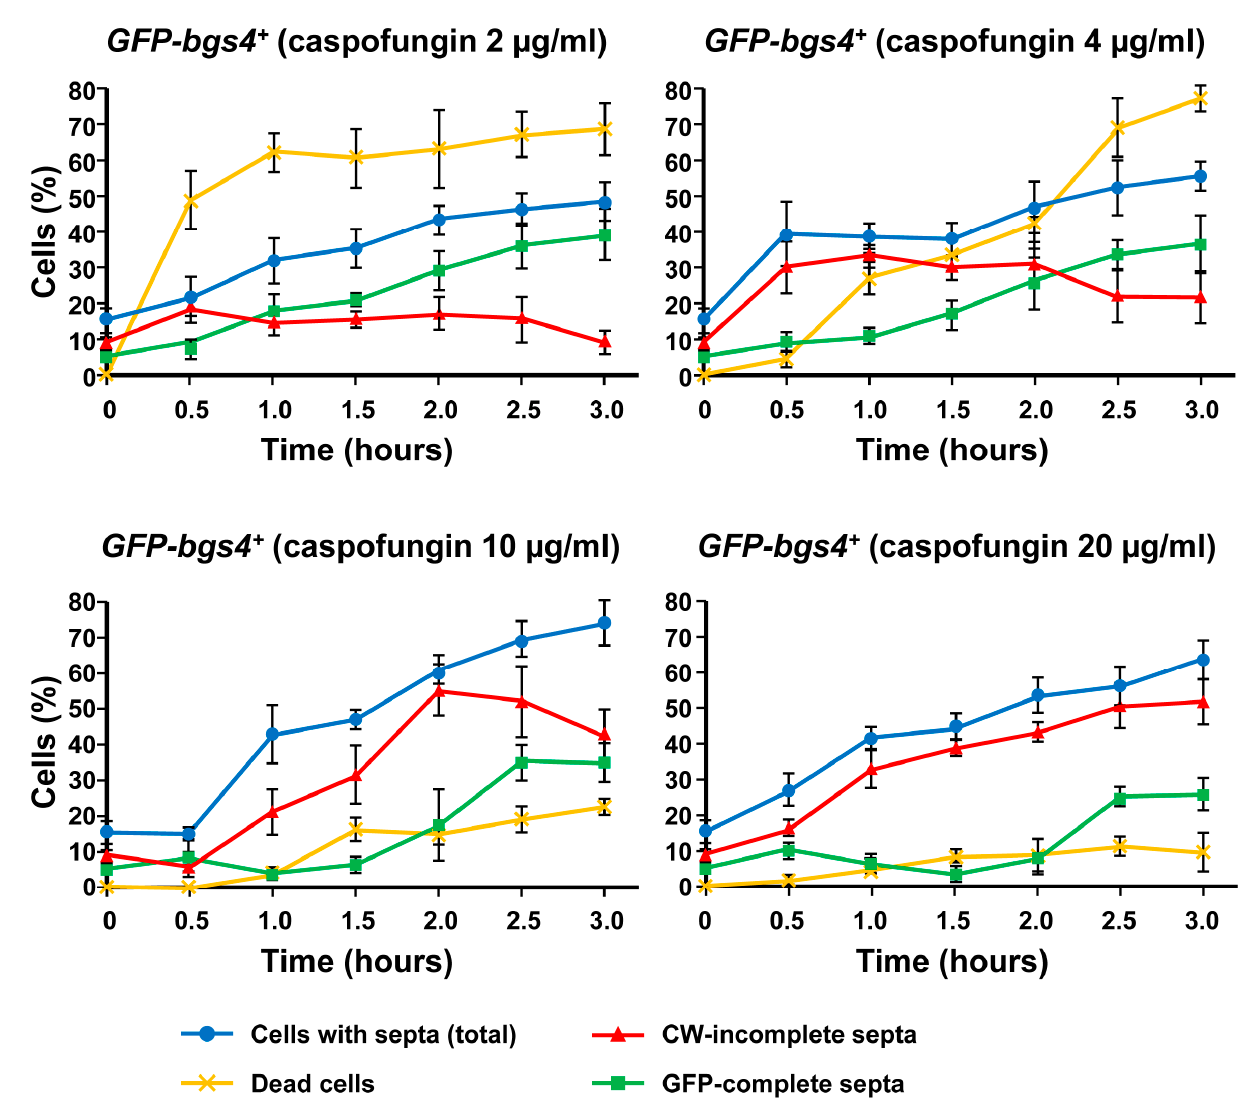
Figure 7. Percentages of the total GFP-bgs4 + dead cells (yellow line), CW-stained total septa (blue line), CW-incomplete septa (red line), and GFP-complete septa (green line) either in the absence (time 0 h) or in the presence of sublethal (2 and 4 µ g/mL) and lethal (10 and 20 µ g/mL) concentrations of caspofungin. Cells were grown and imaged at the indicated times and drug concentrations as in Figure 3. Error bars indicate standard deviation.